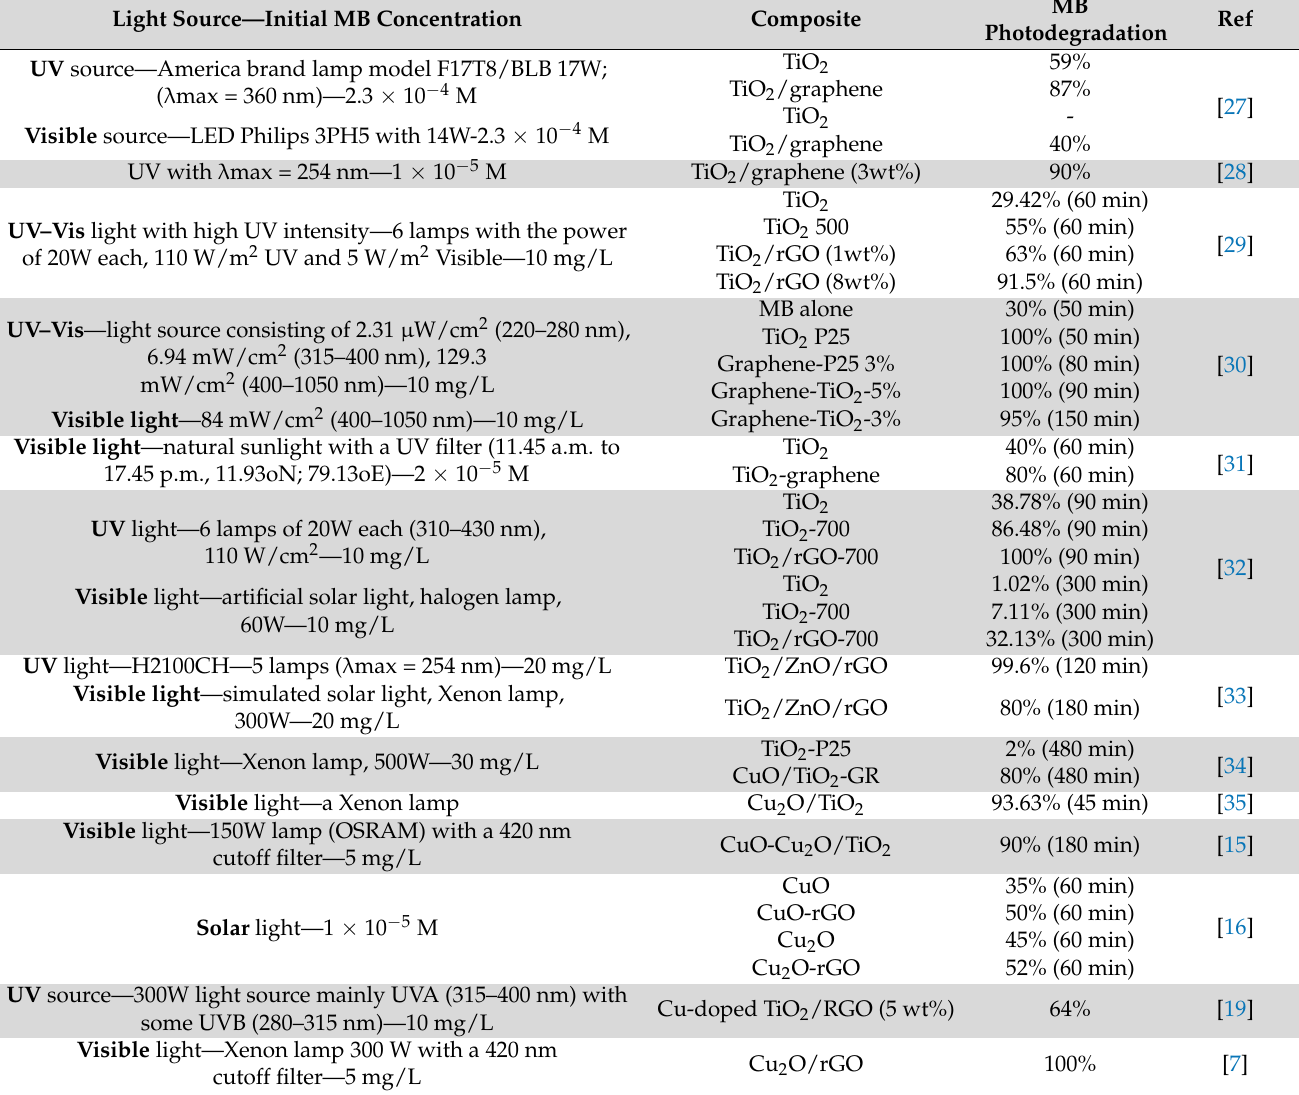
Table 2. Comparison of literature data on methylene blue photodegradation under different TiO 2 - containing catalysts and light exposure